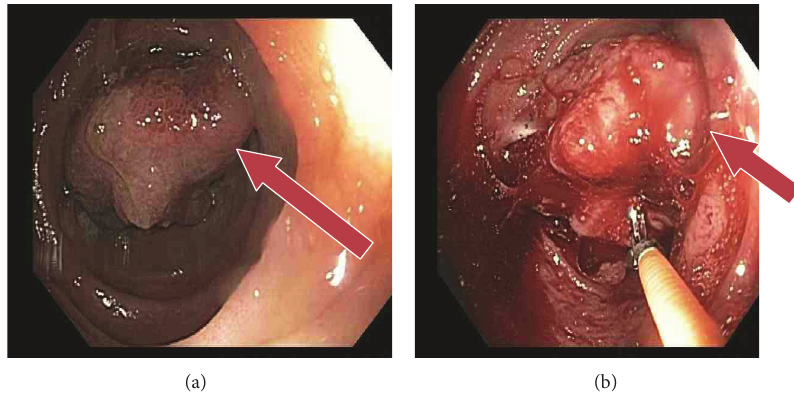
Figure 2: (a) Showing colonoscopy view of mass in the terminal ileum. (b) Showing biopsy of the lesion.